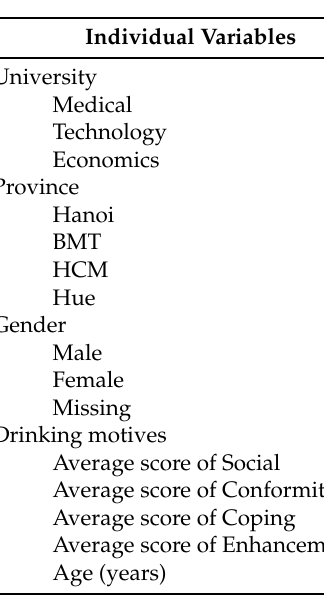
Table 1. Demographic and individual characteristics of drinkers ( n =